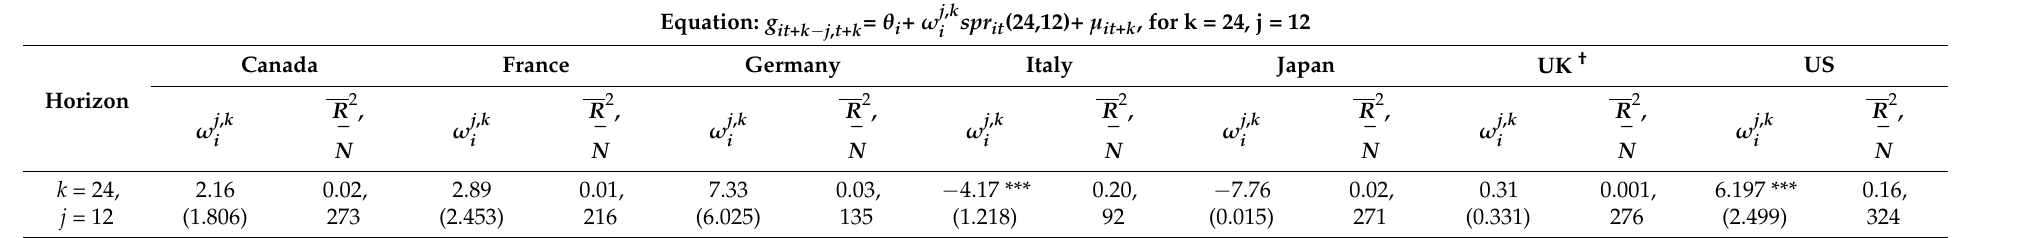
Table A2. Economic activity from the term spread—marginal